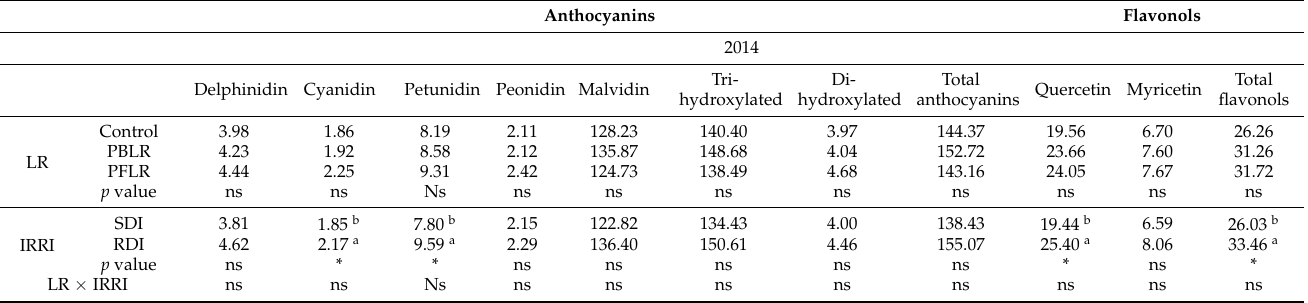
Table 4. Wine flavonoid concentration in a Merlot ( Vitis vinifera L.) vineyard in Denair, California in 2014 and 2015 a,b,c